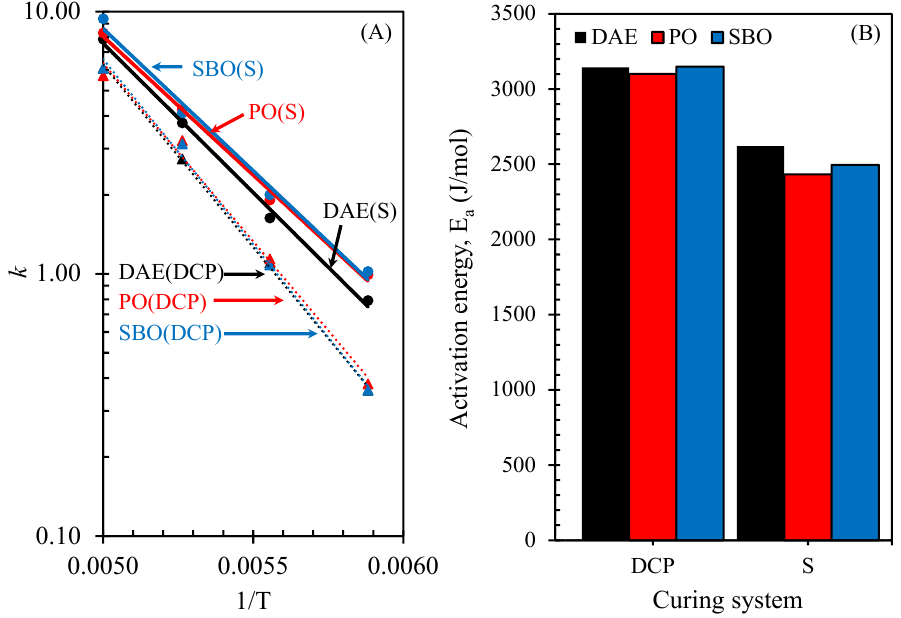
Figure 8. lnk versus 1/T ( A ) and activation energy ( B ) of NR compounds containing different types of oils under various curing systems.